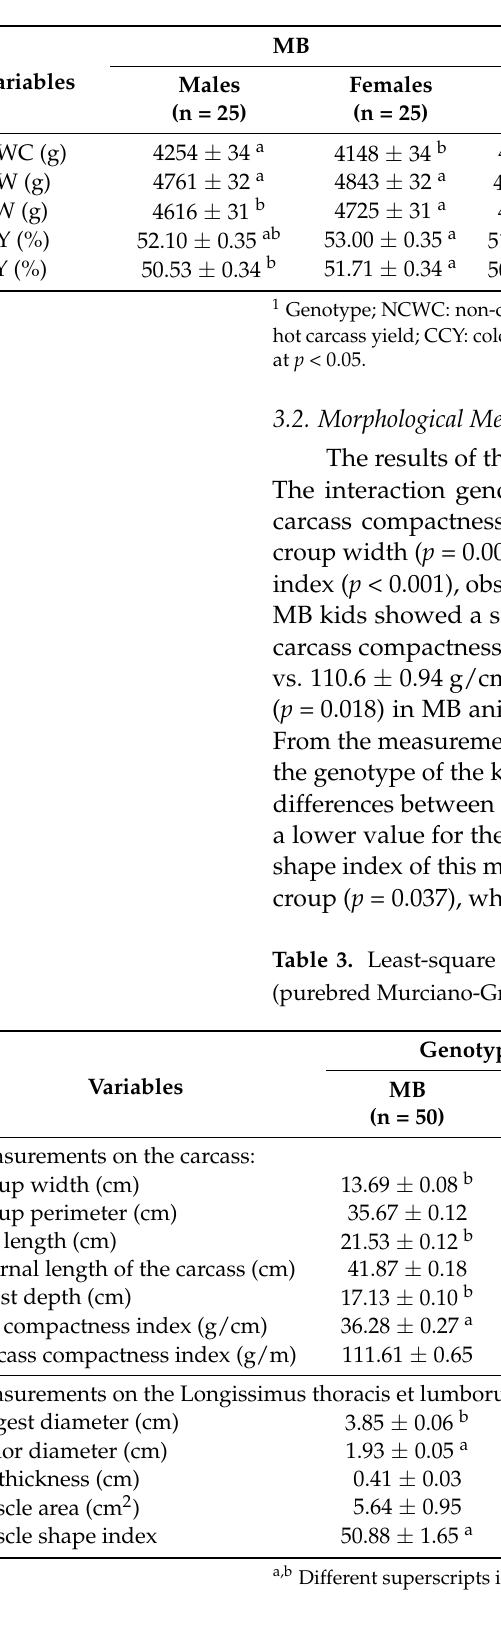
Table 2. Least-square means ( ± SE) for total non-carcass weight components, carcass weight and dressing percentage from kids according to genotype (purebred Murciano-Granadina (MG) or crossed with Boer (MB)) and sex.